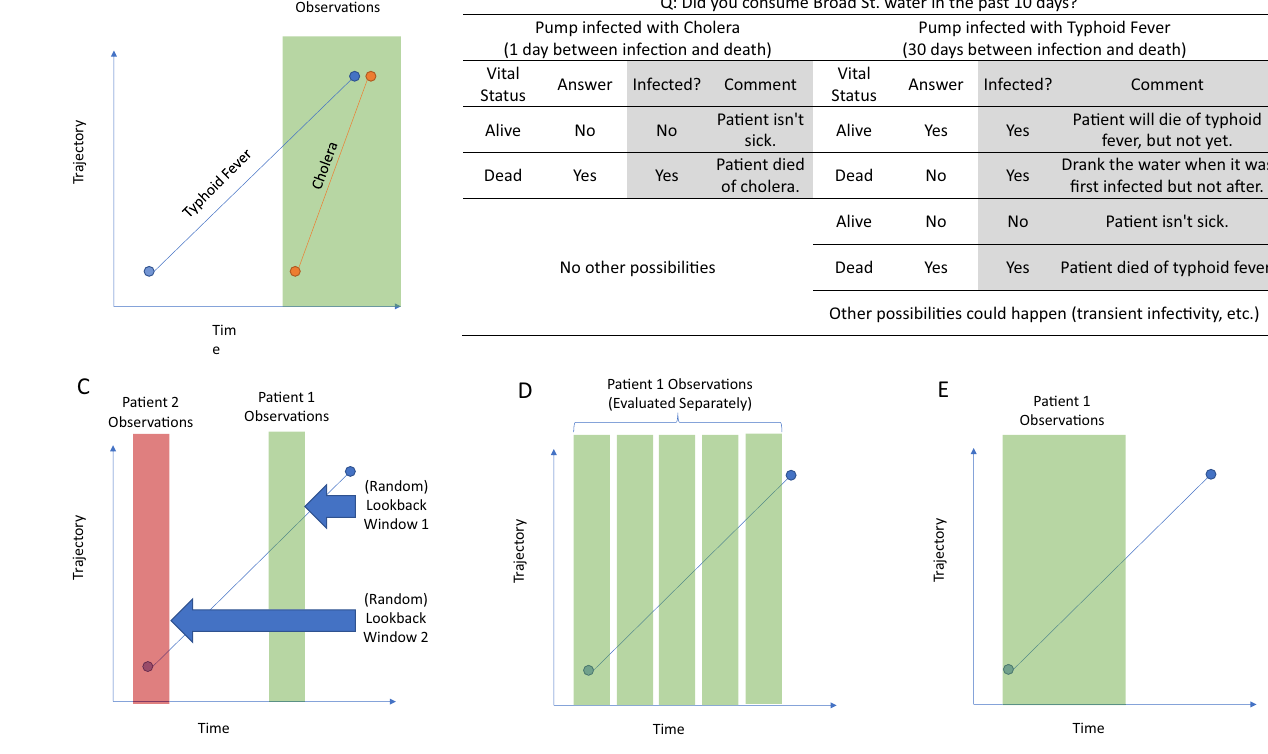
Fig. 4 Preventing temporal bias. A Whitehead ’ s cholera study bene fi ted from the short period between infection and death. Had Whitehead been faced with an outbreak of typhoid fever, his sampling strategy would oversample late-stage features. B Hypothetical interview data from Whitehead ’ s case-control study. Lacking underlying knowledge regarding disease etiology, Whitehead ’ s experimental design would have experienced temporal bias given a disease with a longer incubation period. Shaded columns represent information hidden to the investigator. C Randomizing the lookback window among case patients can uniformly sample the trajectory, if the lookback times go far back enough. D Evaluating person-days, person-weeks, or person-months can allow for the entire trajectory to be considered. E Conducting a cohort study by creating a well-de fi ned date from which a look forward window is deployed does not uniformly sample the trajectory in all individuals, but is still prospectively implementable since the starting date can be determined in real